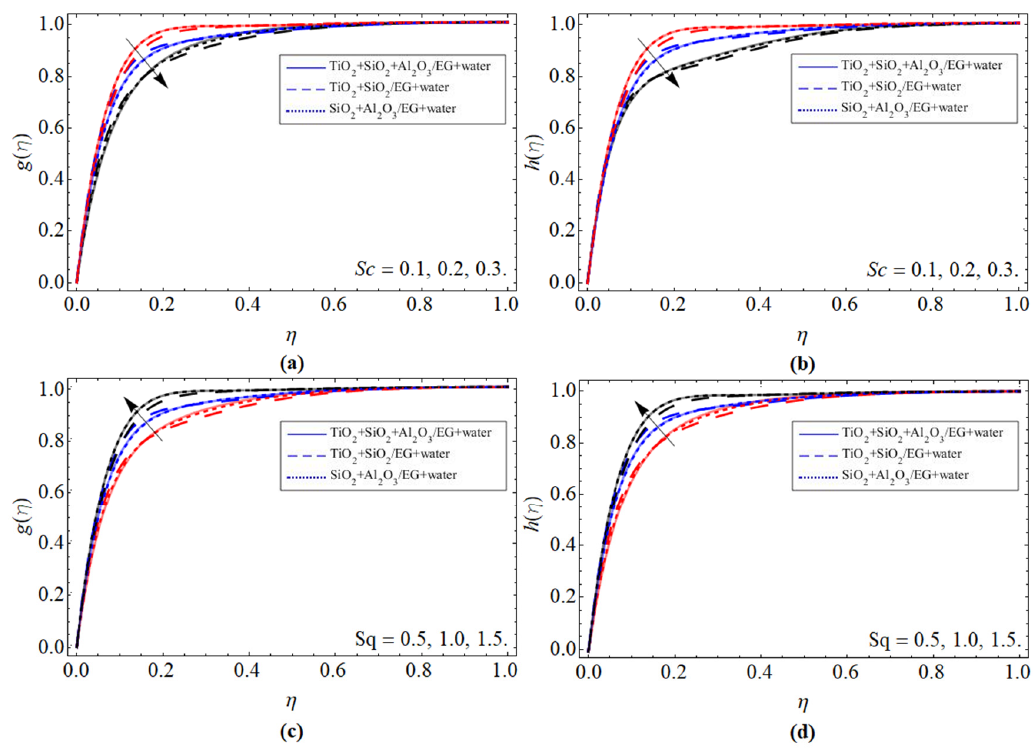
Figure 3. The tendency of electric field ( g ( η ), h ( η )) versus ( a , b ) Schmidt number Sc , ( c , d ) squeezing term Sq .